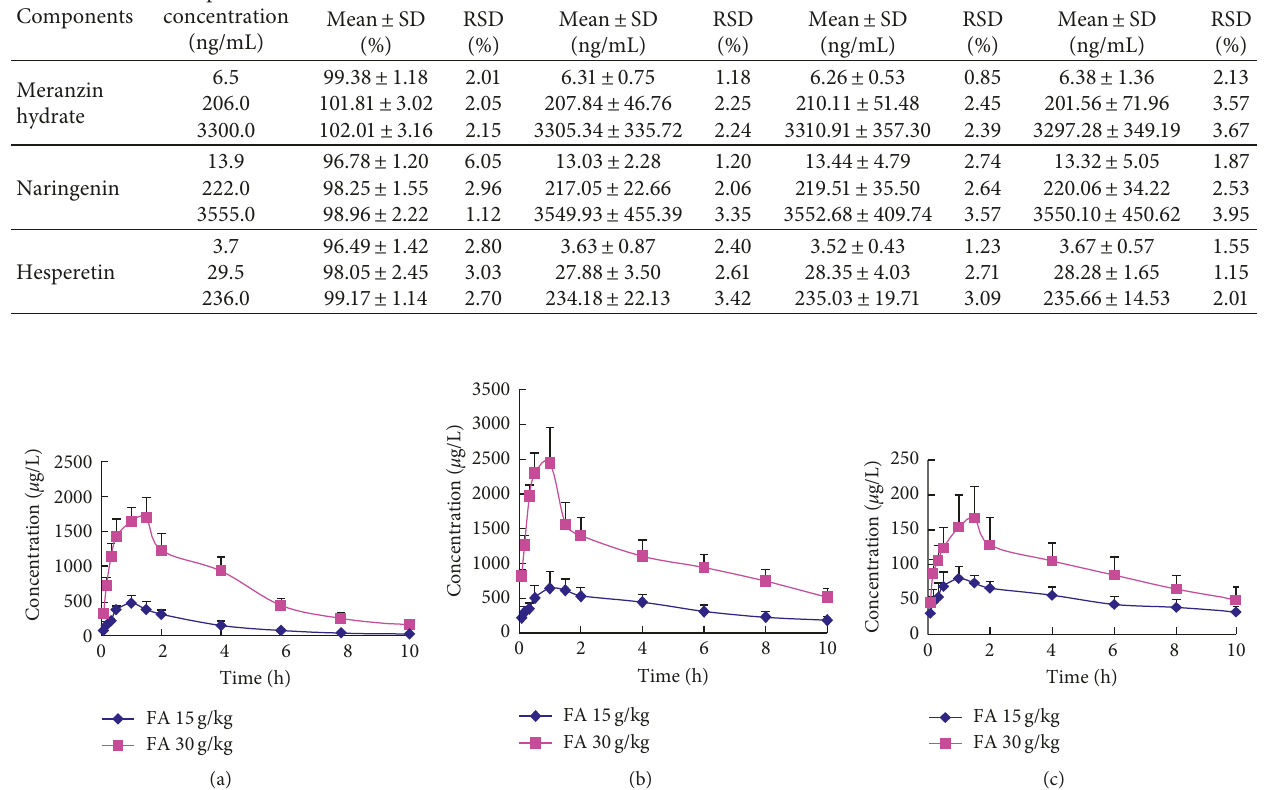
Table 4: Extraction recoveries and stability of meranzin hydrate, naringenin, and hesperetin in rat plasma. Components Meranzin hydrate